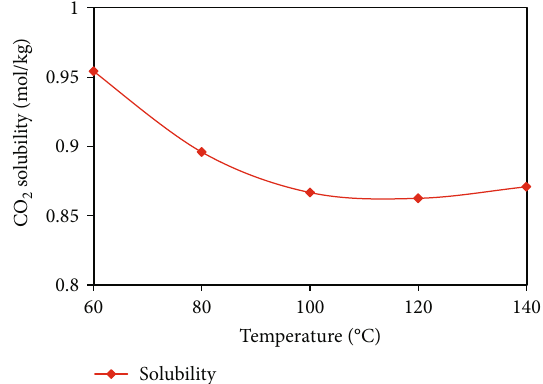
Figure 5: Solubility of CO